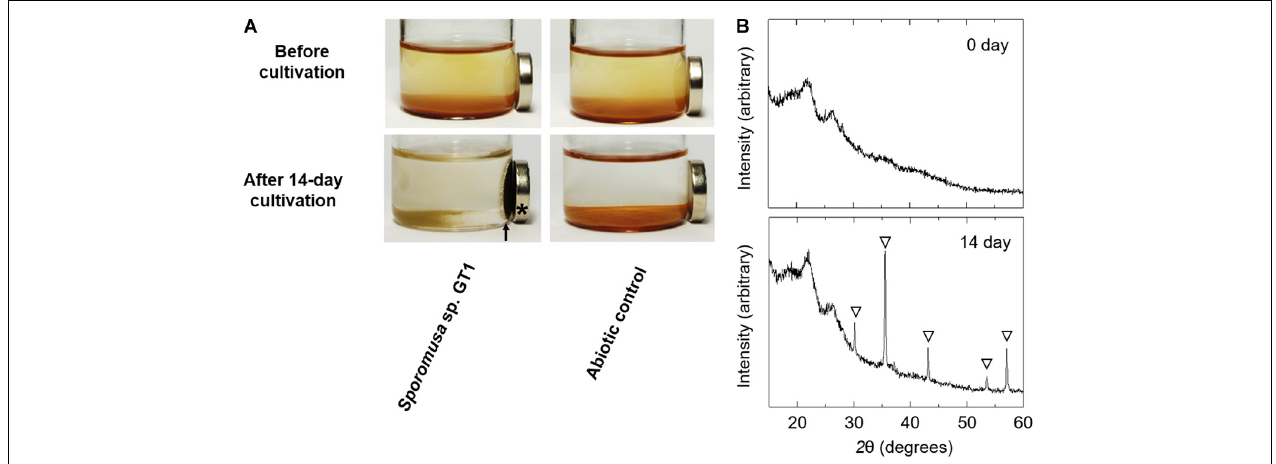
FIGURE 7 | Transformation of HFO to magnetite by ethanol-grown culture of strain GT1. Strain GT1 was cultivated on ethanol (20 mM) in the presence of HFO under phosphate-limiting conditions. (A) Appearance culture bottles. Asterisk indicates a magnet. Arrow indicates magnet-attracted sediment. (B) Powder X-ray diffraction patterns of the sediments from the ethanol-grown culture of strain GT1. Open triangle, peaks from magnetite.